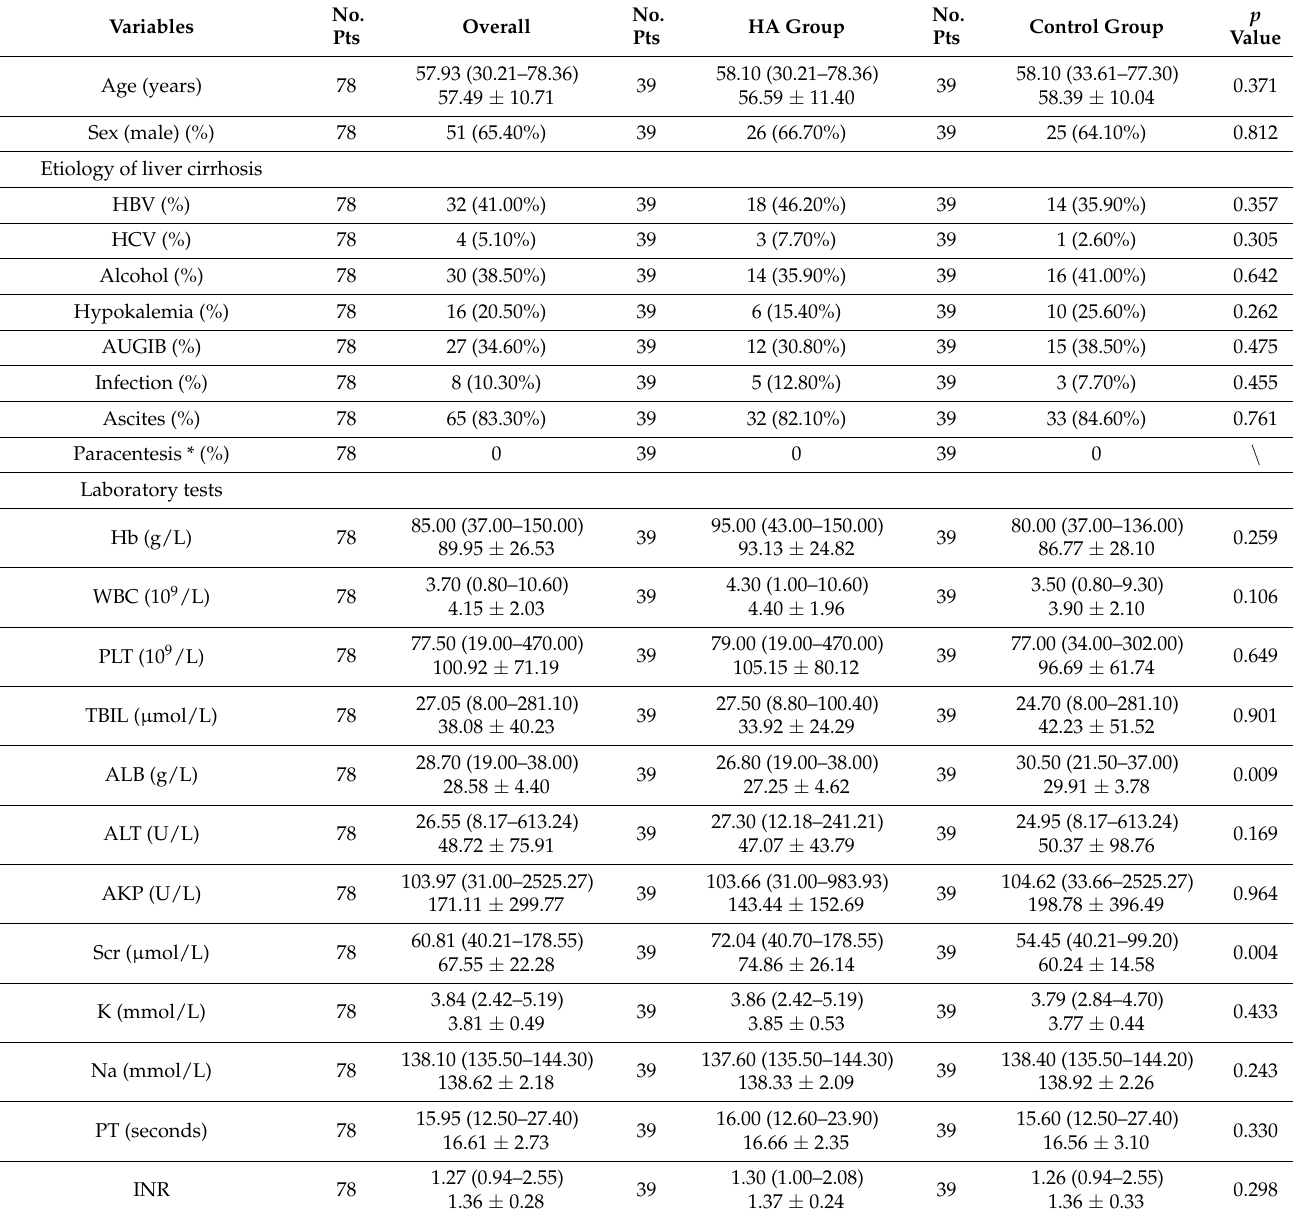
Table 3. Long-term outcome cohort—Characteristics of patients in the prevention study after